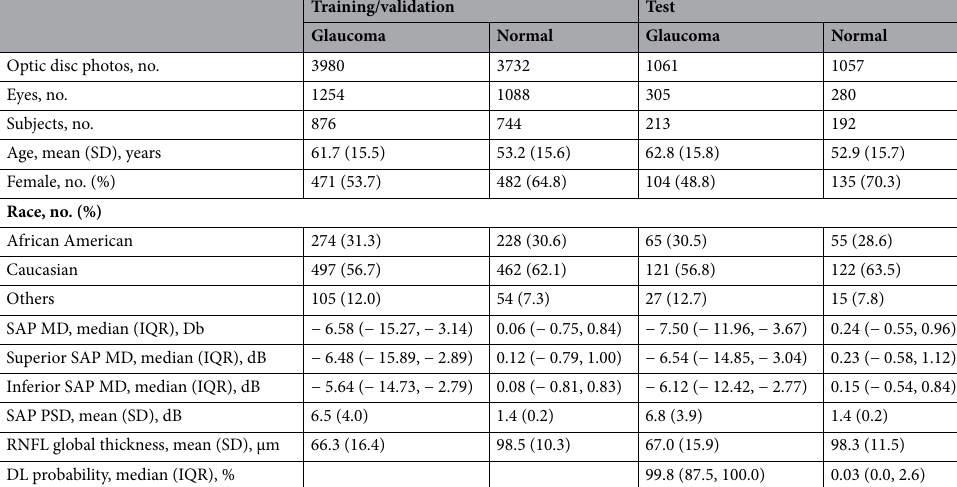
Table 2. Demographic and clinical information of eyes and individuals included in the study. No. number, SD standard deviation, SAP standard automated perimetry, MD mean deviation, IQR interquartile range, PSD pattern standard deviation, RNFL retinal nerve fibre layer, DL deep